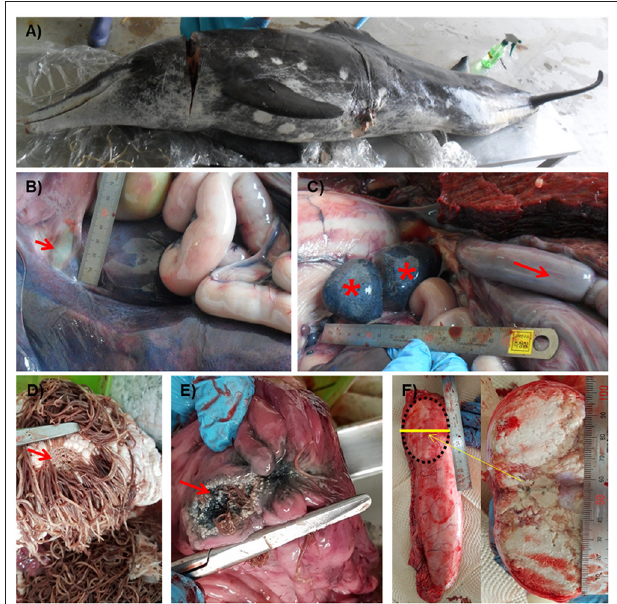
FIGURE 1 | Gross lesions of a Steno bredanensis that died from septicemia caused by Erysipelothrix rhusiopathiae . (A) Overall external features of the dead dolphin. (B) The bile duct to the duodenum. Trematodes were observed in the duct, liver, and pyloric stomach (arrow). (C) Spleen and accessory spleen with petechiae (asterisk), enlarged and congested intestine (arrow). (D,E) Severe Anisakis infection formed ulcers (arrow) on the forestomach (D) and main stomach (E) walls. (F) Caseous exudate fills capsule formed in the